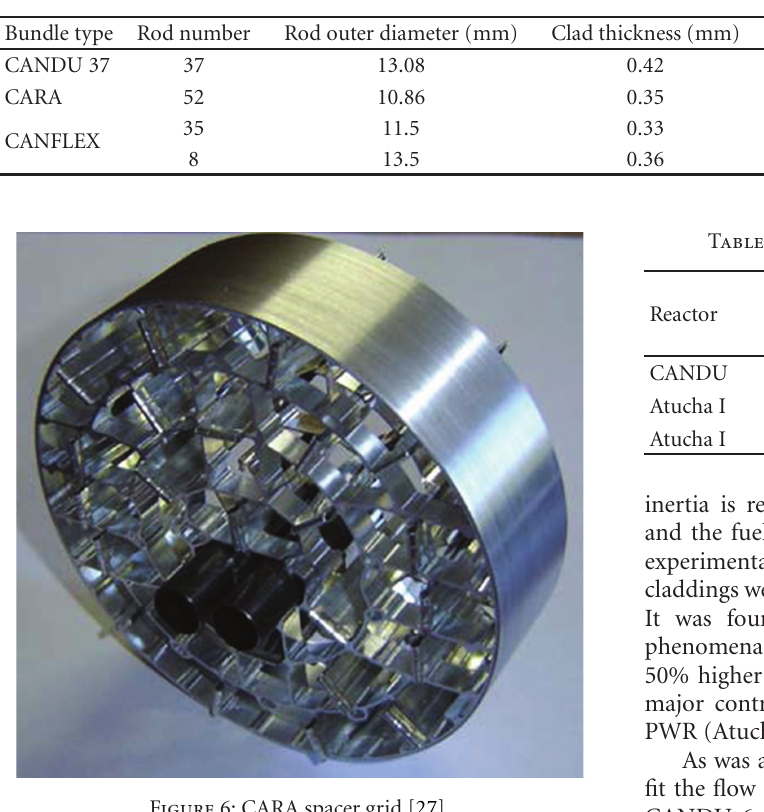
Table 9: Bundle characteristic of CANDU FEs.